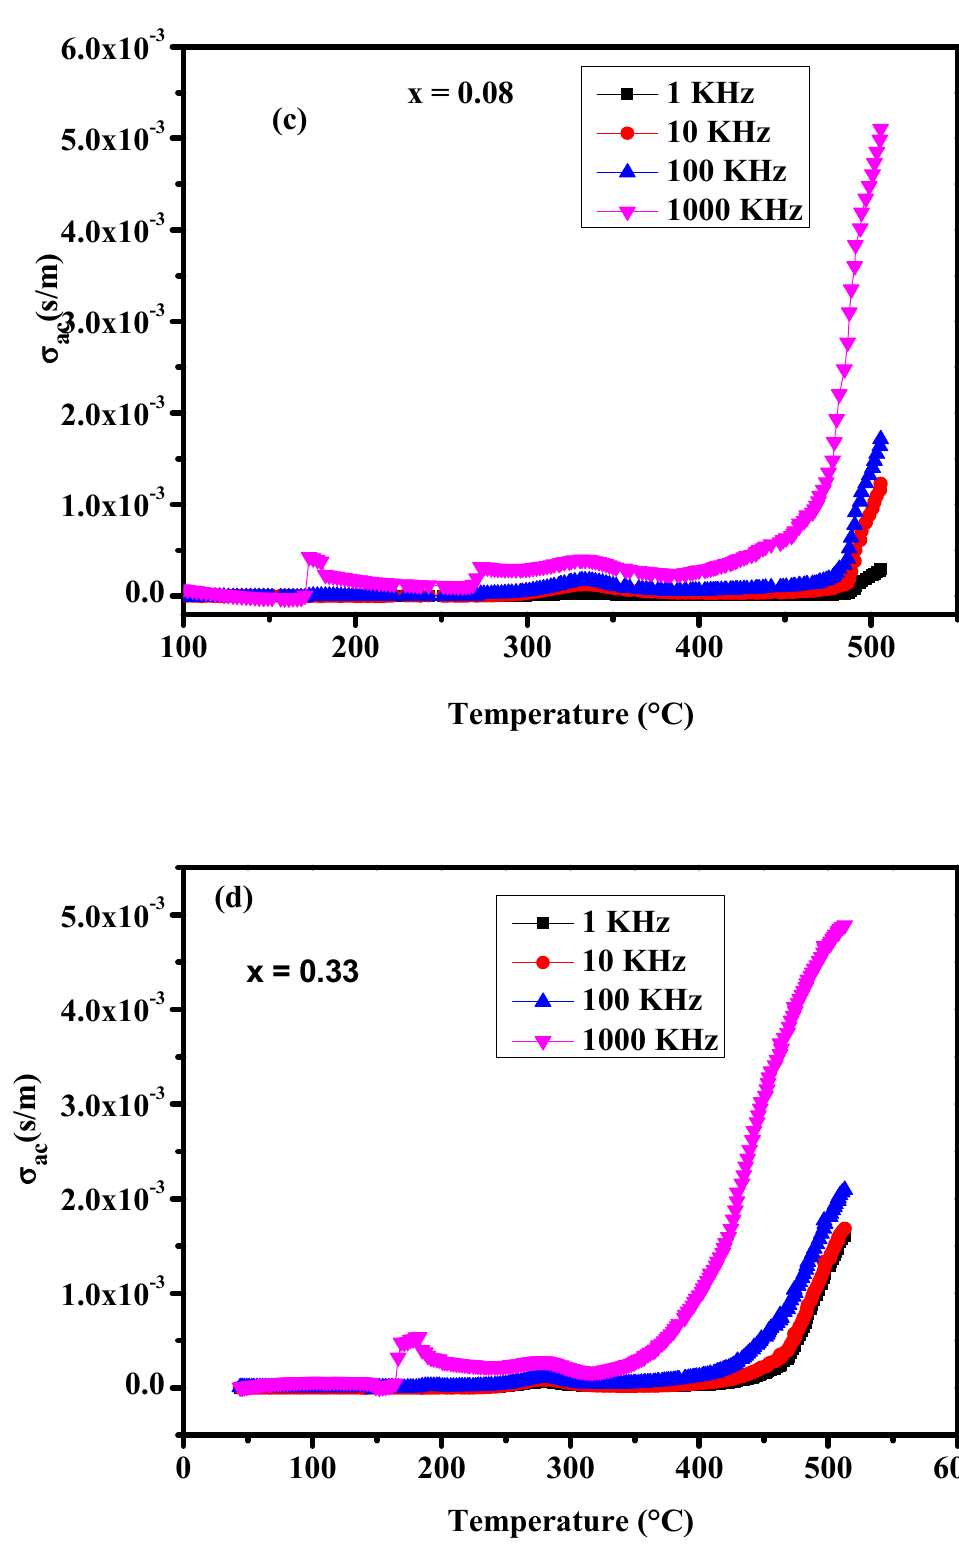
Figure 7. ( a – d ) Thermal development of electrical conductivity at different frequencies for the ceramics.